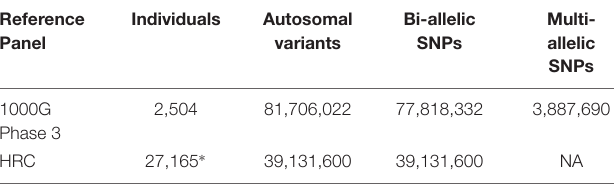
TABLE 1 | SNP counts in HRC and 1000G reference